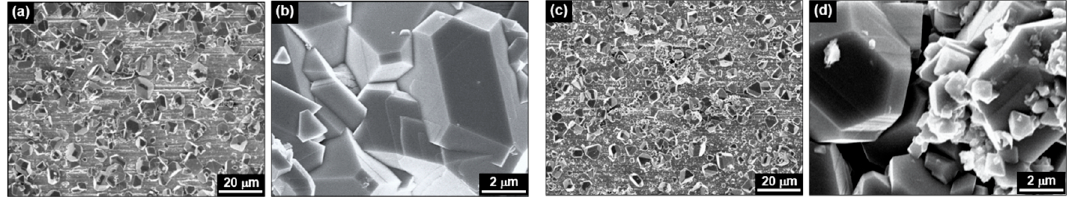
Figure 2. SEM micrographs of fuel deposits formed ( a , b ) under the no ‐ zinc condition (Case #1) and ( c , d ) at the 20 ppb zinc concentration (Case #2). ( c , d ) at the 20 ppb zinc concentration (Case